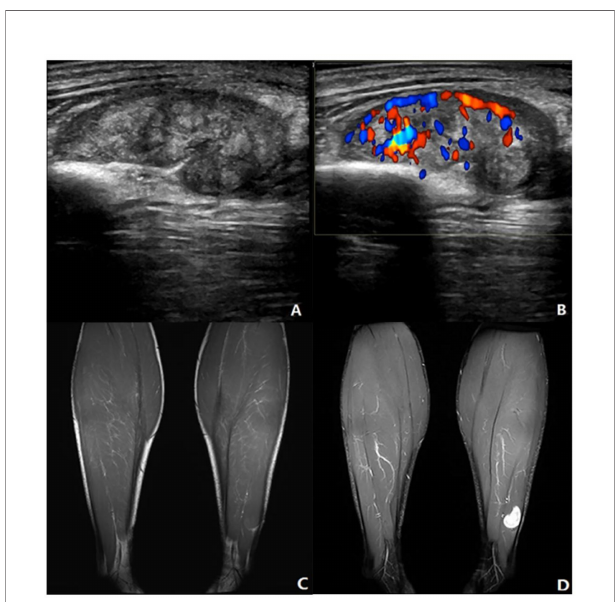
FIGURE 4 | Neurinoma of lower extremity. A 41-year-old male presented with a mass in the left lower leg. (A) Longitudinal grayscale US showed a well-de fi ned and heterogenous mass with maximum diameter of 34 mm in the peroneal brevis muscle. (B) Color Doppler imaging of the same area showed hypervascularity within the tumor, corresponding to type IV. (C) Coronal T1WI showed a homogeneous isointensity mass. (D) The lesion had homogeneous high SI on the coronal fat-suppressed T2WI with maximum diameter of 20 mm. (A, B) A score of 2 was assigned, indicating a benign tumor (true positive). (C, D) A score of 0 was assigned, indicating a benign tumor (true positive).